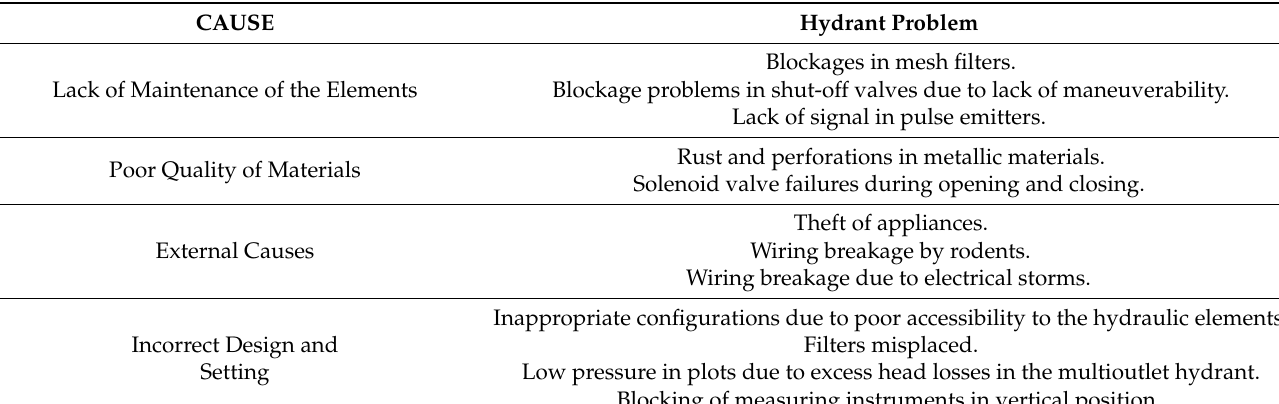
Table 3. Grouping the main problems in multioutlet